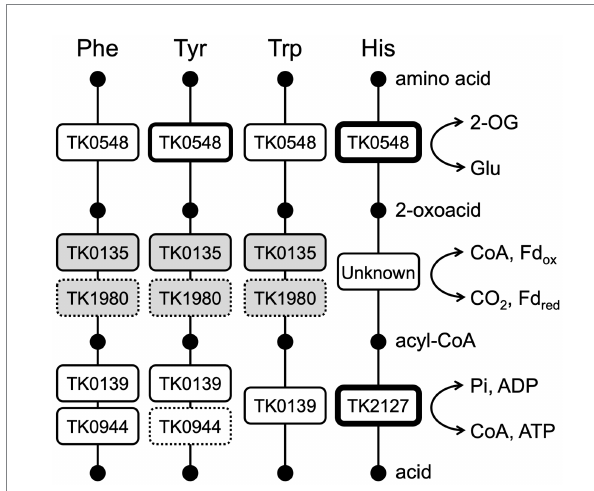
FIGURE 8 A diagram illustrating the involvement of aminotransferases, 2-oxoacid:ferredoxin oxidoreductases, and acyl-CoA synthetases in the catabolism of Phe, Tyr, Trp, and His in T. kodakarensis . Enzymes with greater roles in each step are indicated with boxes with thicker lines, and those with minor roles are indicated by dotted lines. Gene numbers of the acyl-CoA synthetases indicate those of the α subunit. TK0135 represents TK0135-0136, TK1980 represents TK1978-1981. The genes in white boxes are based on biochemical and genetic evidence and the shaded boxes are predicted based on similarity to the experimentally examined enzymes from P. furiosus . 2-OG, 2-oxoglutarate; CoA, coenzyme A; Fd, ferredoxin; Pi,